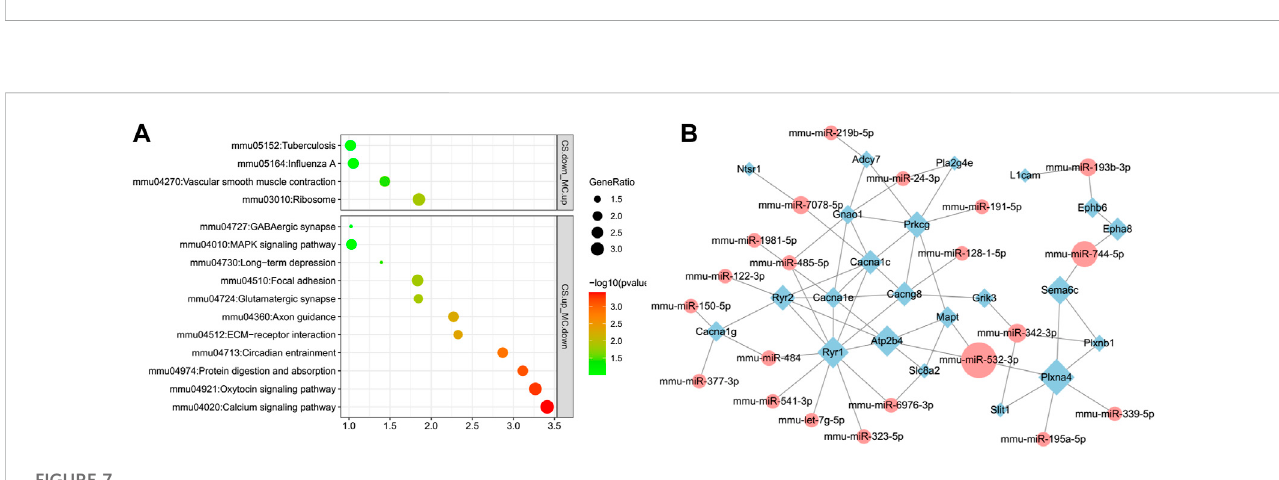
FIGURE 7 Pathways and network visualization of the DEGs targeted by DE-miRNAs induced by cocaine and inhibited by MET. (A) Enriched pathways of predicted DEGs targeted by DE-miRNAs downregulated in the MC group and upregulated in the CS group, and upregulated in the MC group and downregulated in the CS group. (B) Network of DE-miRNAs and their target DEGs in the enriched substance dependence and addiction-related pathways. Diamonds, DEGs; ellipses, miRNAs; green, downregulated; red,